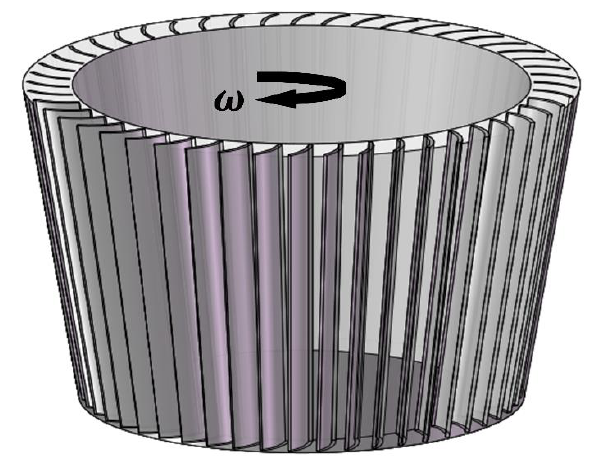
Figure 12. Schematic diagram for the streamlined blade. The cloud diagram for the radial velocity distribution and relative velocity